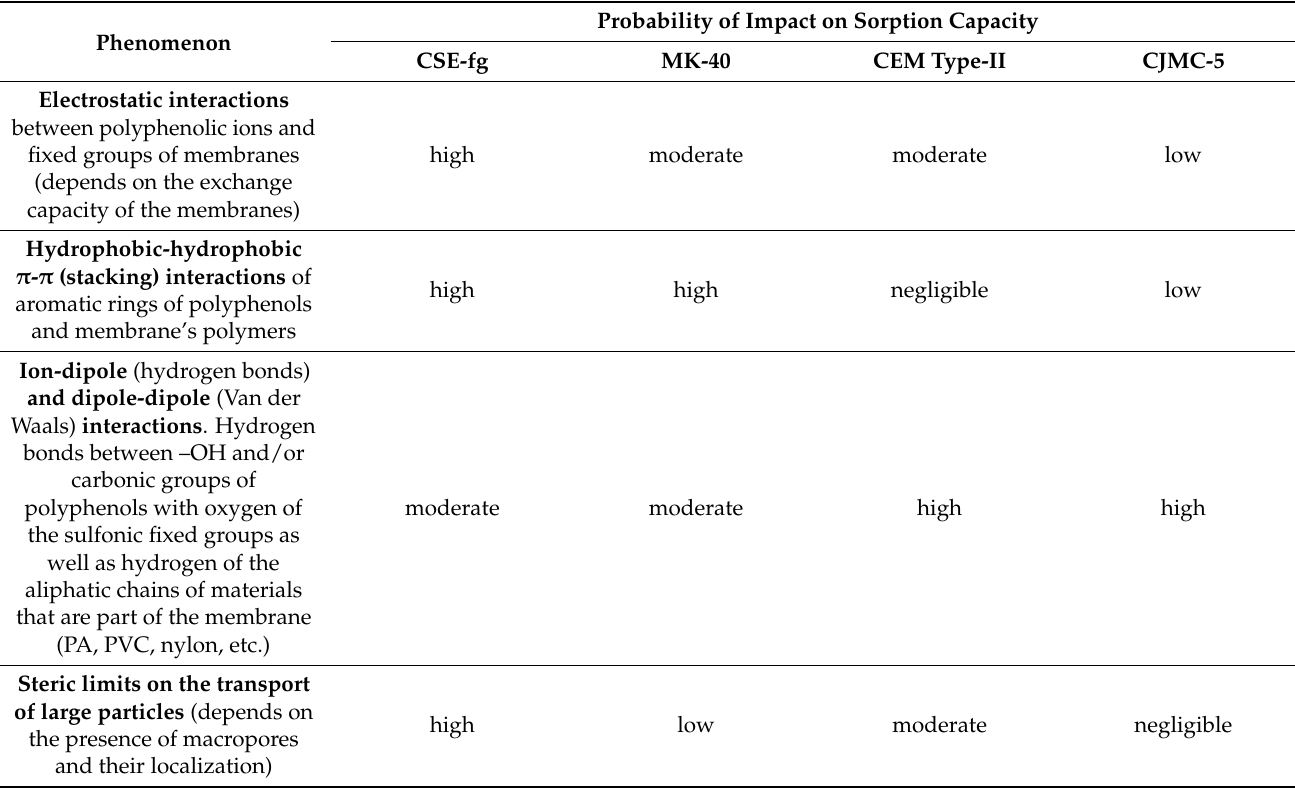
Table 9. Main phenomena affecting the sorption of polyphenols from cranberry juice on membranes.